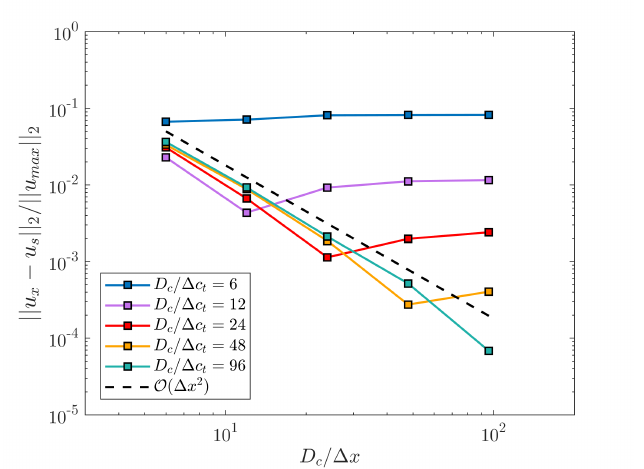
Figure 9. Combined influence of the ratios D c / ∆ c t and D c / ∆ x on the convergence of the